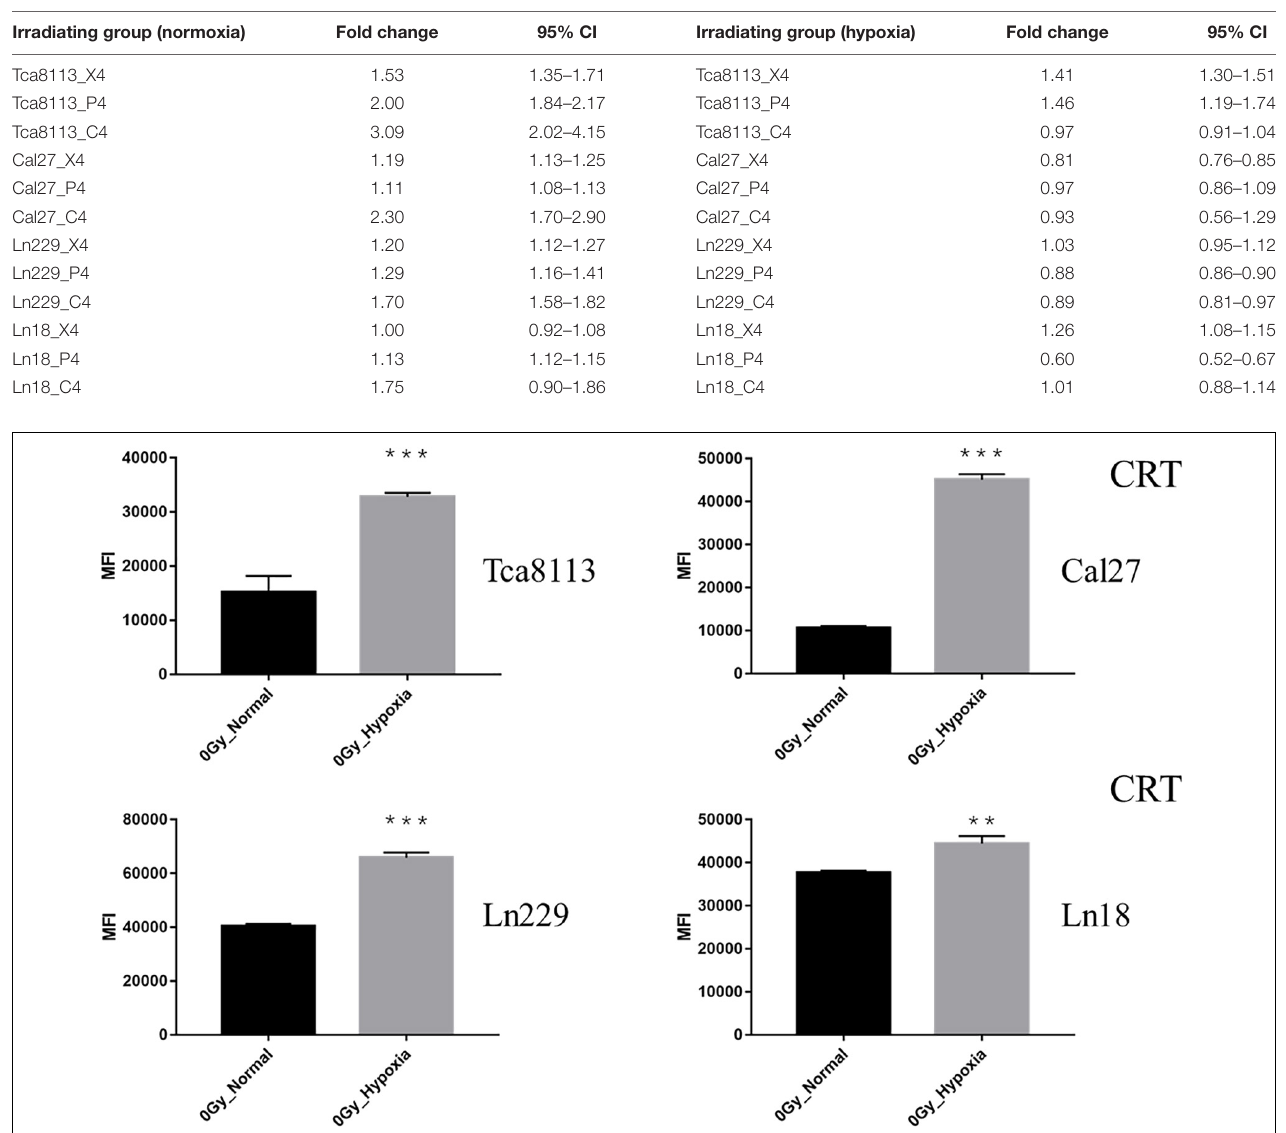
FIGURE 4 | Comparison of baseline CRT expression under normoxia and hypoxia. The expression of CRT on the tumor cell surface was detected by flow cytometry. The MFI of each tumor cell line under normoxia and hypoxia is shown in the histogram. Results are presented as mean ± s.d. Each experiment was repeated at least three times. Statistical significances of the difference between cells under normoxia and hypoxia are indicated by asterisks. ** p < 0.01, *** p <